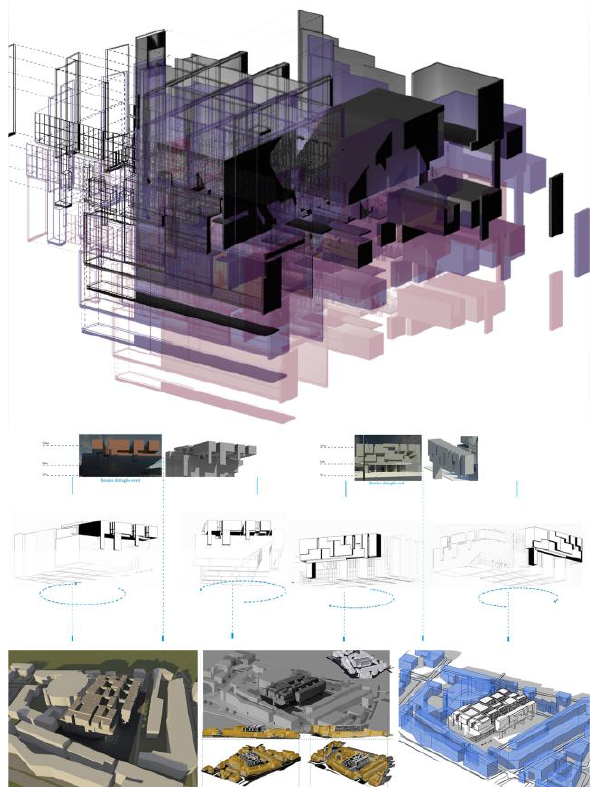
Figure 9 . New Bocconi University headquarters in Milan - Grafton building in via Röntgen (2008). Computational Representation, Visual area: Evolutionary knowledge. Brera Academy of Fine Arts Milan (A. De Masi).